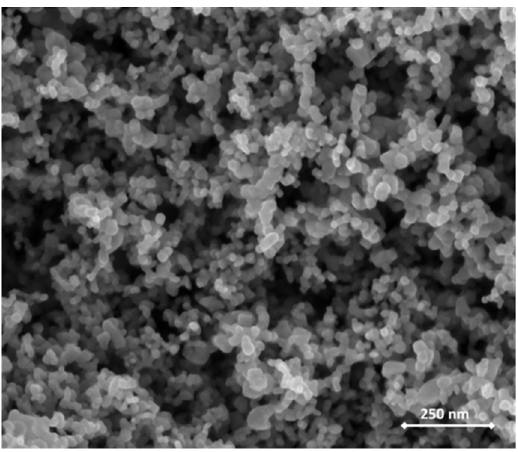
Figure 2. SEM image of the TiO 2 layer showing a 20 nm particle